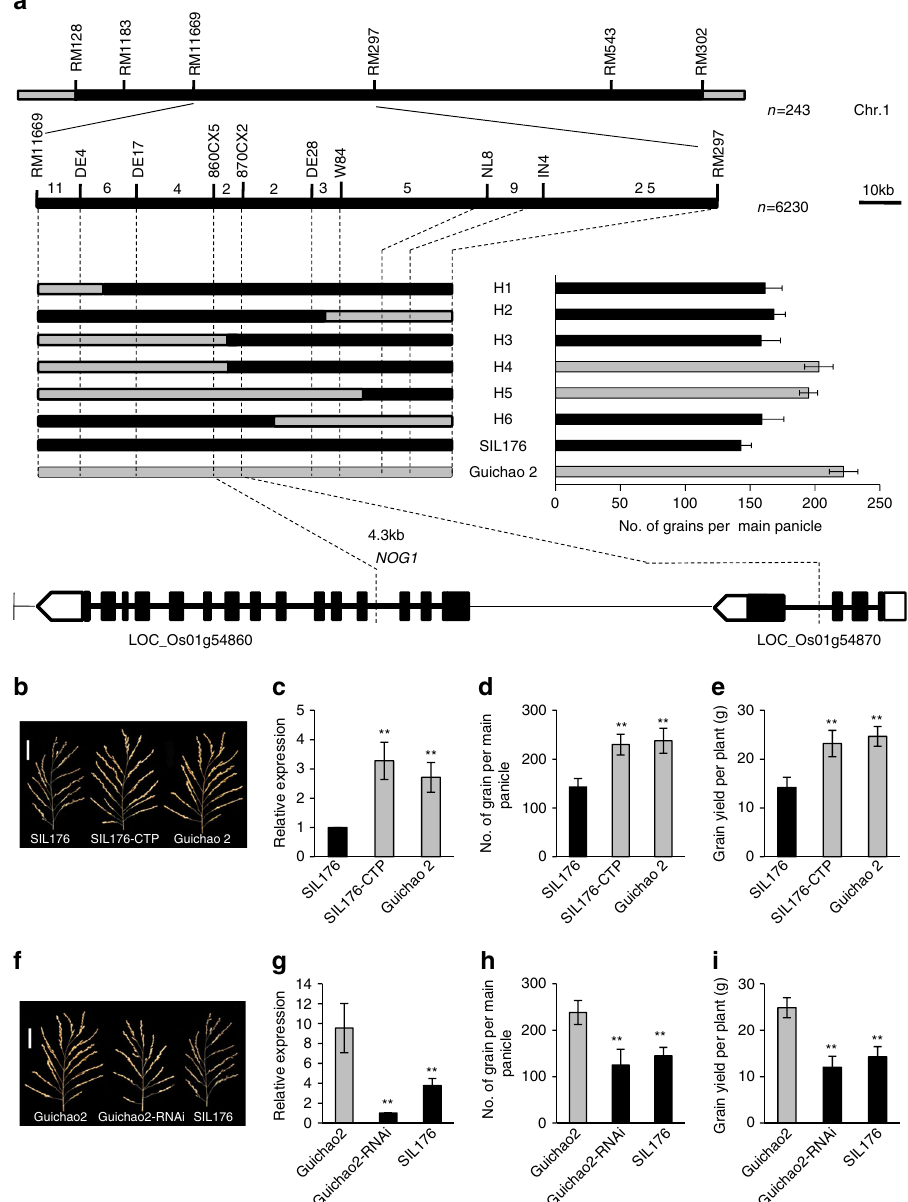
Fig. 2 Mapping and cloning of NOG1 . a The NOG1 locus was detected on chromosome 1. Positional cloning narrowed the NOG1 locus to a 4.3-kb region between 860CX5 and 870CX2. The numbers above the bars indicated the number of recombinants. LOC_Os01g54860 was the candidate gene. b The main panicle of SIL176 (control), complemented transgenic plants (SIL176-CTP), and Guichao 2. Scale bars, 5 cm. c Comparison of the relative expression levels of NOG1 among SIL176, SIL176-CTP, and Guichao 2 ( n = 4). d , e Comparison of grain number per main panicle and grain yield per plant among SIL176, SIL176-CTP, and Guichao 2 ( n = 30). f The main panicle of Guichao 2 (control), RNAi transgenic plants (Guichao 2-RNAi), and SIL176. Scale bars, 5 cm. g Comparison of the relative expression levels of NOG1 among Guichao 2, Guichao 2-RNAi, and SIL176 ( n = 4). h , i Comparison of grain number per main panicle and grain yield per plant among Guichao 2, Guichao 2-RNAi, and SIL176 ( n = 30). Data are means, with error bars showing SEM (two-tailed Student ’ s t test; ** P <